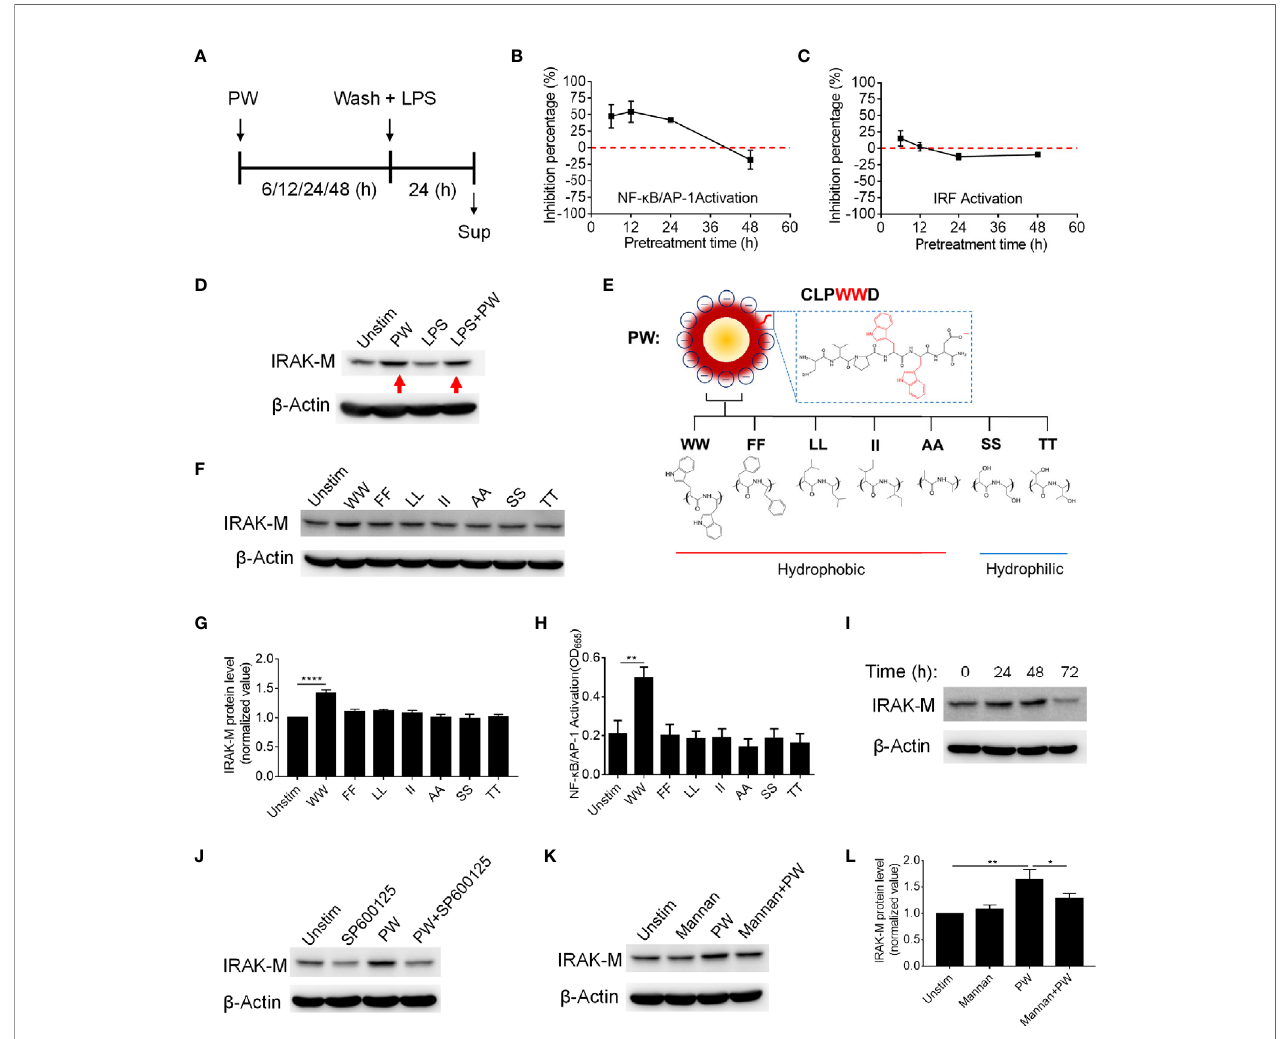
FIGURE 6 | The priming effects of PW on the TLR4 inhibition in relationship with the tryptophan dependent expression of IRAK-M in THP-1-derived macrophages. (A) The scheme of PW priming (100 nM) for different time periods (6, 12, 24 and 48 h) followed by LPS stimulation (10 ng/mL) for 24 h. (B, C) The time effect of PW pre-treatment on its inhibitory capacity on the activation of NF- k B/AP-1 (B) and IRF (C) upon LPS stimulation. (D) Immunoblotting showing the IRAK-M expression at 24 h induced by PW (100 nM) in the absence and presence of LPS (10 ng/mL) stimulation; b -actin as the internal control. (E) A scheme showing the mutation of two adjacent tryptophan residues (WW) in the peptide coating of PW to other two hydrophobic amino acids: phenylalanine (FF), leucine (LL), isoleucine (II) and alanine (AA) or hydrophilic amino acids: serine (SS) and threonine (TT). (F) The effect of the mutated hybrids (100 nM) displaying different amino acid residues on the IRAK-M expression at 24 h by immunoblotting; b -actin as the internal control. (G) Quanti fi cation of the IRAK-M expression in (F) . (H) The effect of the mutated hybrids (100 nM) on the NF- k B/AP-1 activation in the THP-1 reporter cell-derived macrophages. (I) The time course of IRAK-M expression induced by PW (100 nM); b -actin as the internal control. (J) Immunoblotting showing the IRAK-M expression at 24 h induced by PW (100 nM) in the absence and presence of SP600125 (10 µM); b -actin as the internal control. (K) Immunoblotting showing the IRAK-M expression at 24 h induced by PW (100 nM) with/without the pretreatment of mannan (5 µg/mL) for 0.5 h; b -actin as the internal control. (L) Quanti fi cation of the IRAK-M expression in (K) . N ≥ 3, *p < 0.05, **p < 0.01, ****p <